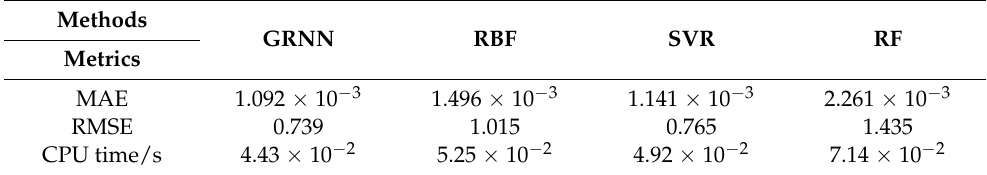
Figure 9. Box plot of training relative error results based on different machine learning algorithms. Table 2. The prediction results under training data.